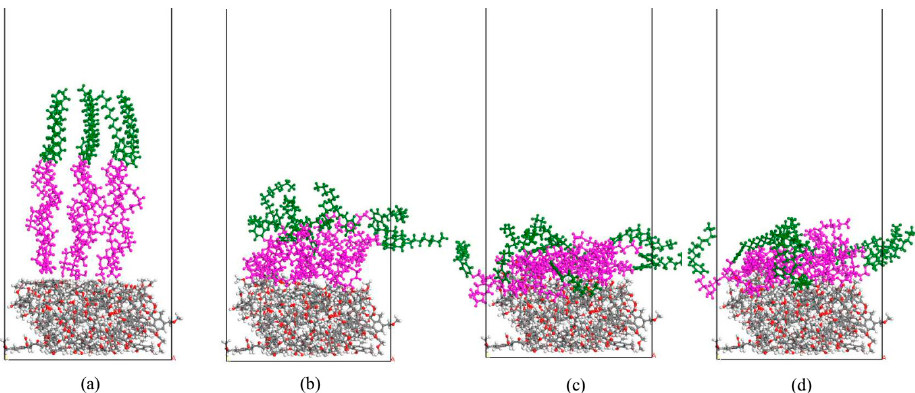
Figure 3. Simulation snapshot of NPEO 10 (nonylphenol: green, and ethoxylate: purple) aggregates on lignite surface for different simulation times. The snapshots are taken at 0 ps, 250 ps, 500 ps, and 1 ns for ( a – d ) respectively (O: red, C: gray and H: white). For clarity, the water molecules are not shown.